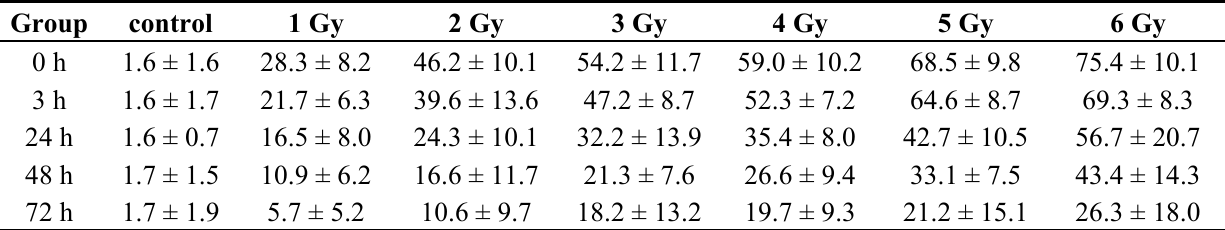
Table 2. DNA DSBs olive tail moment (OTM) in lymphocytes after irradiation with various doses within 72 h ( x ±